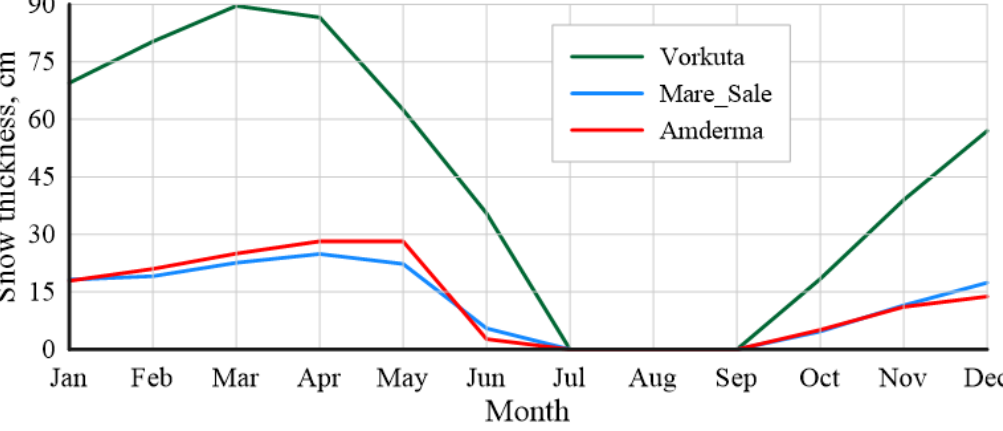
Figure 5. Annual snow cover thickness (average for 2013 – 2020) at three meteorological stations: Vorkuta, Mare-Sale, and Amderma.